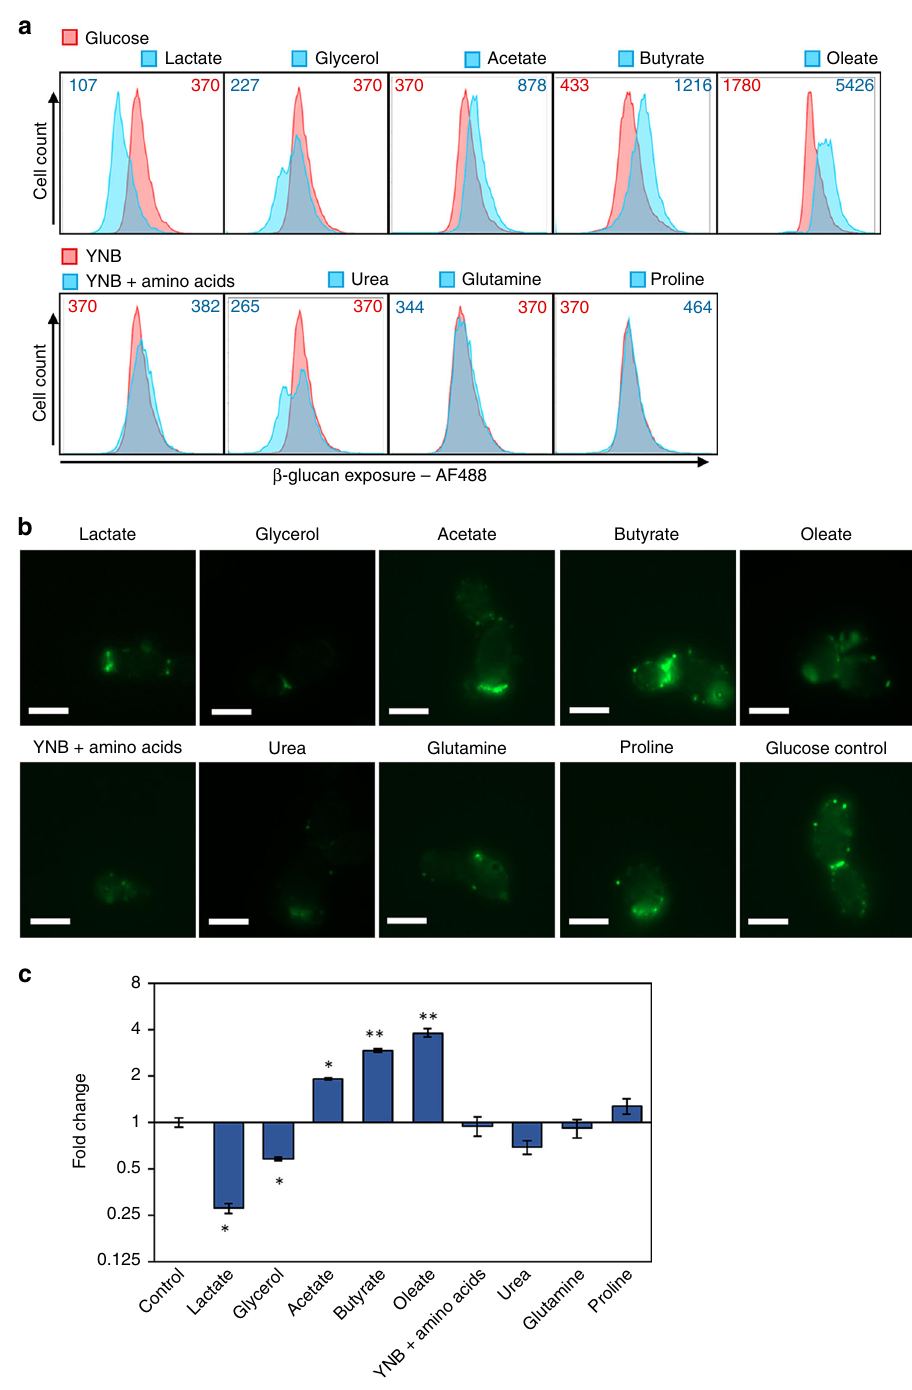
Fig. 1 Certain nutrients impact β -glucan exposure at the C. albicans cell surface. C. albicans SC5314 cells (Supplementary Table 1) were grown overnight in minimal medium containing glucose and ammonia as sole carbon and nitrogen sources, respectively (YNB). They were then transferred to fresh YNB media containing different carbon or nitrogen sources, as shown, and grown for a further 5 h. These cells were then fi xed and stained with Fc-dectin-1 to examine β -glucan exposure at their cell surface. a Their β -glucan exposure was quanti fi ed by fl ow cytometry (Supplementary Fig. 4). One of three independent experiments are shown for each condition. The median fl uorescence intensity (MFI) for each population is indicated: pink, glucose and YNB controls for changes in carbon and nitrogen sources, respectively; cyan, alternative carbon or nitrogen source. b Fluorescence microscopy of cells from the same populations stained for exposed β -glucan (Fc-dectin-1; green): scale bars, 5 μ m. c The fold change in β -glucan exposure for these cell populations calculated relative to the control cells grown with glucose and ammonia. Means and standard deviations from three independent replicate experiments are shown, and the data were analysed using ANOVA with Tukey ’ s multiple comparison test: * p < 0.05; ** p < 0.011. Source data are provided as a Source Data fi